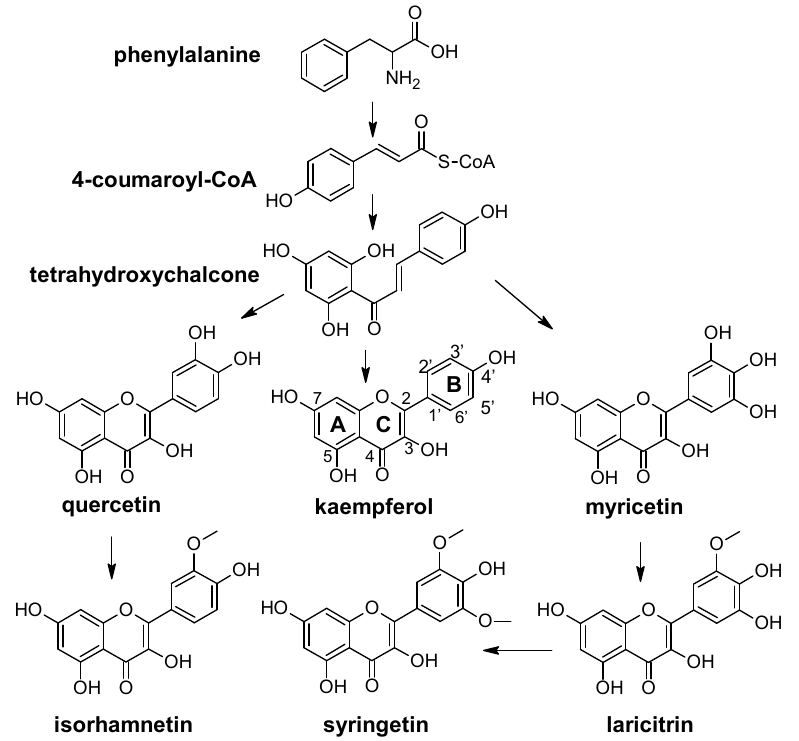
Figure 6. Flavonols pathway. The trihydroxylated flavonols myricetin, laricitrin and syringetin are lacking in the berries of white